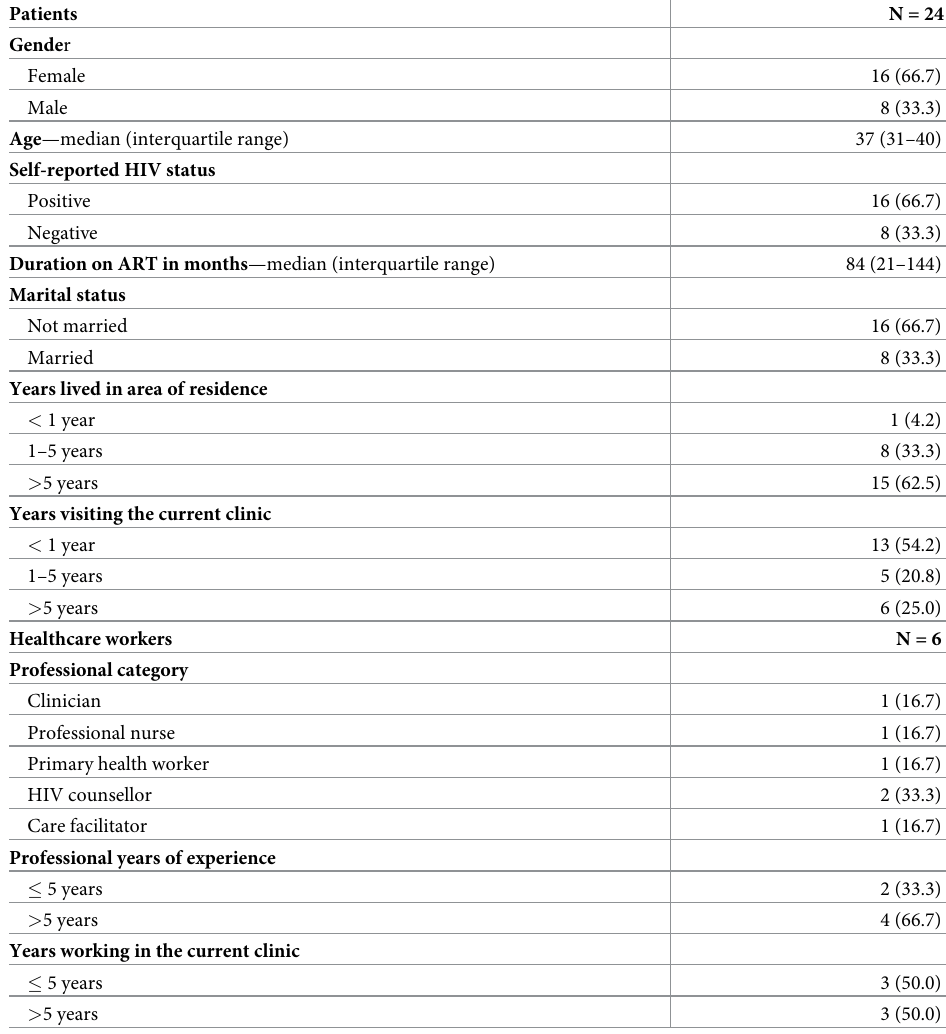
Table 1. Socio-demographic characteristics of